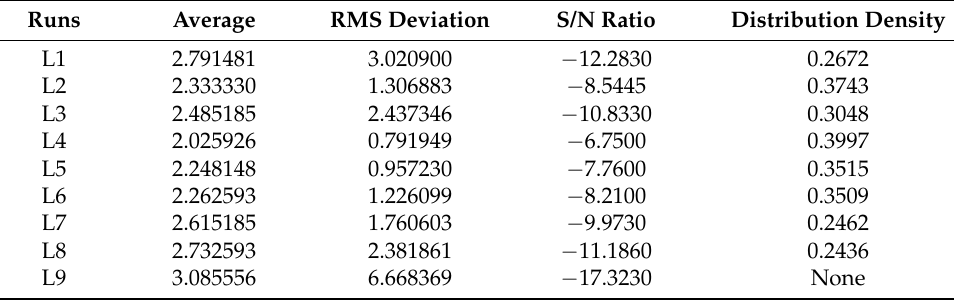
Table 4. S/N ratio for optimum design of microstructure of